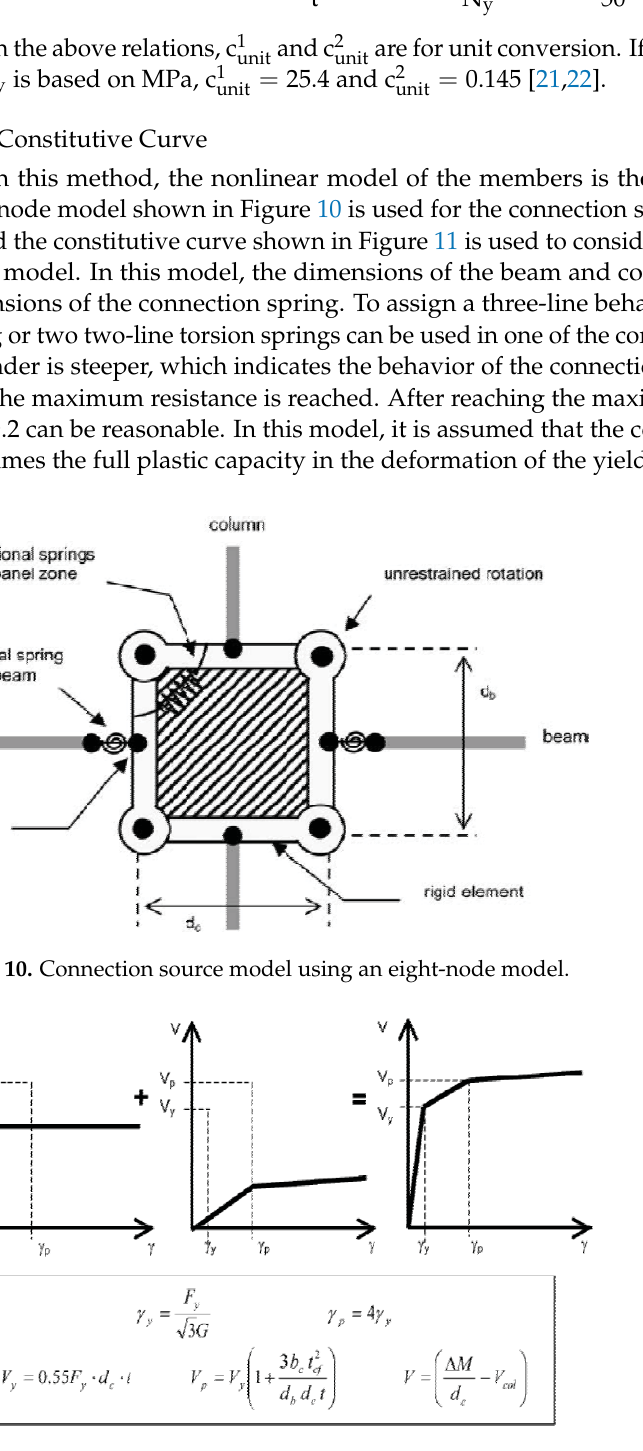
Figure 11. Force behavior displacement of the connection source.